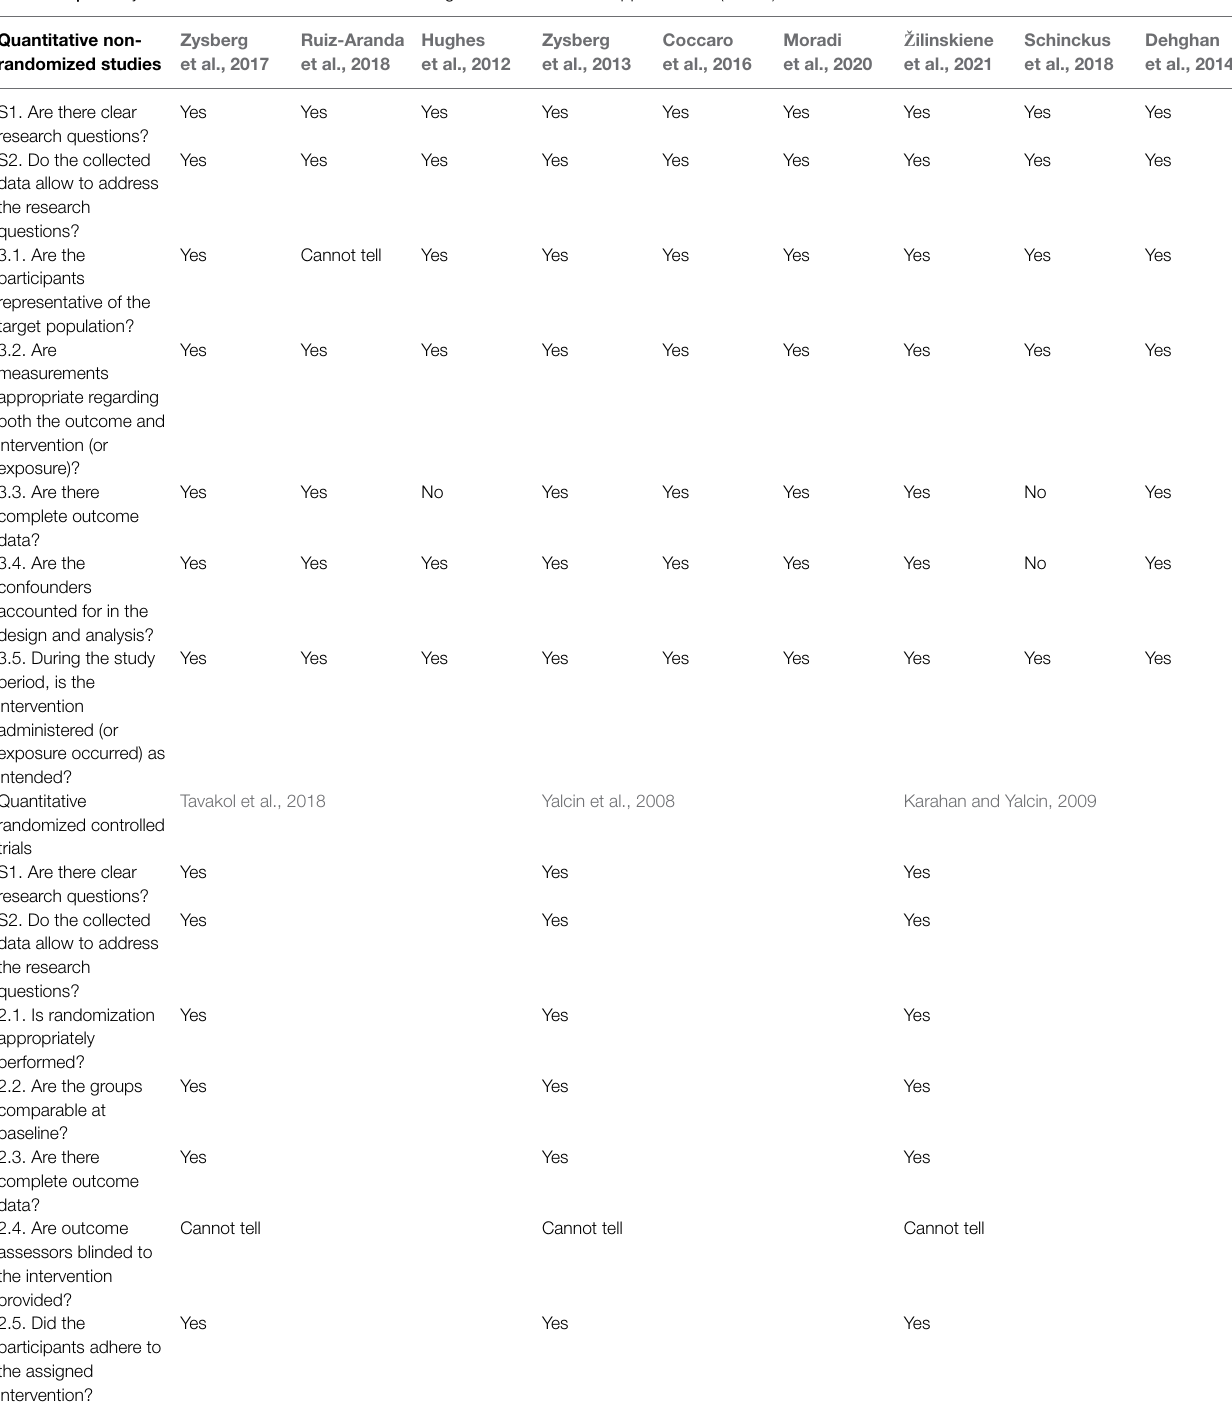
TABLE 1 | Quality assessment of the included studies using the Mixed Methods Appraisal Tool